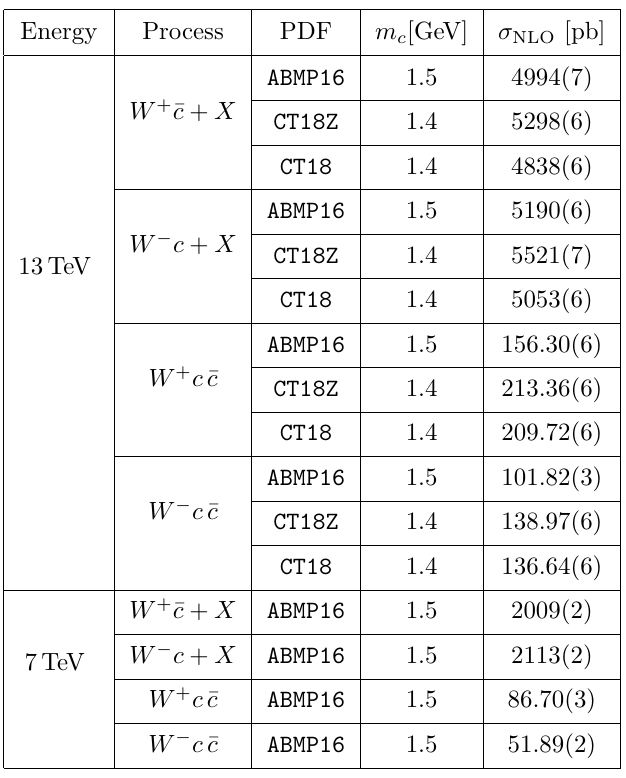
Table 1 . NLO QCD cross sections for fully inclusive W − c + X and W + ¯ c + X production in the √ leptonic channel at s = 13 and 7 TeV for different PDF sets and charm quark on-shell mass values adopted in the rest of this work. The contributions from W ± c ¯ c final states (contributing at the same order and multiplicity as real radiation, though finite) to the full NLO cross section are also reported explicitly. See text for more